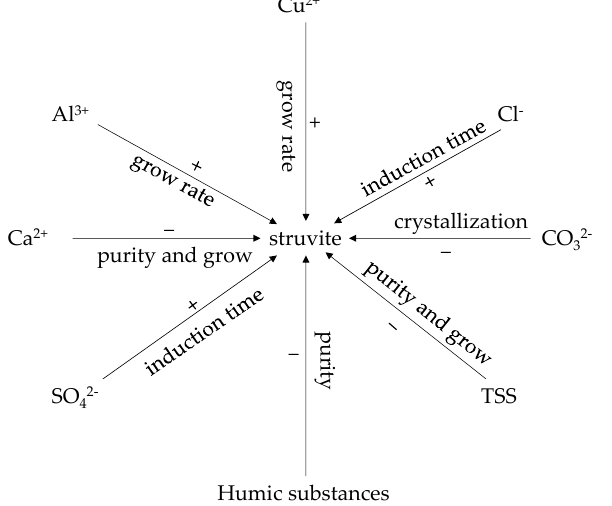
Figure 2. The influence of foreign impurities on struvite: +: positive effect, − : negative effect.